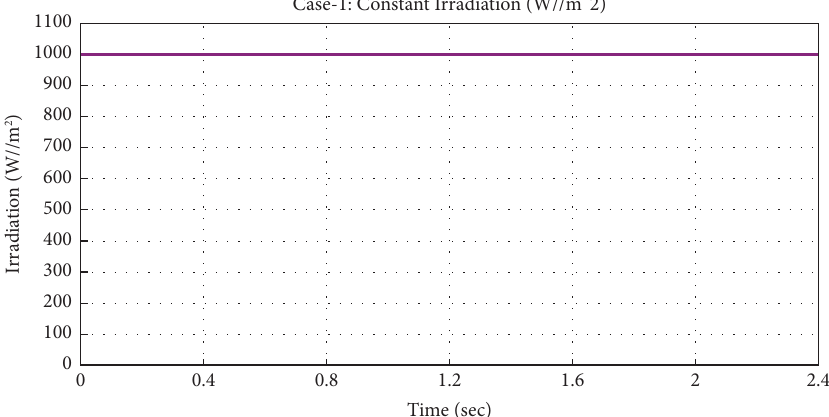
Figure 11: Input solar irradiation in Case 1.